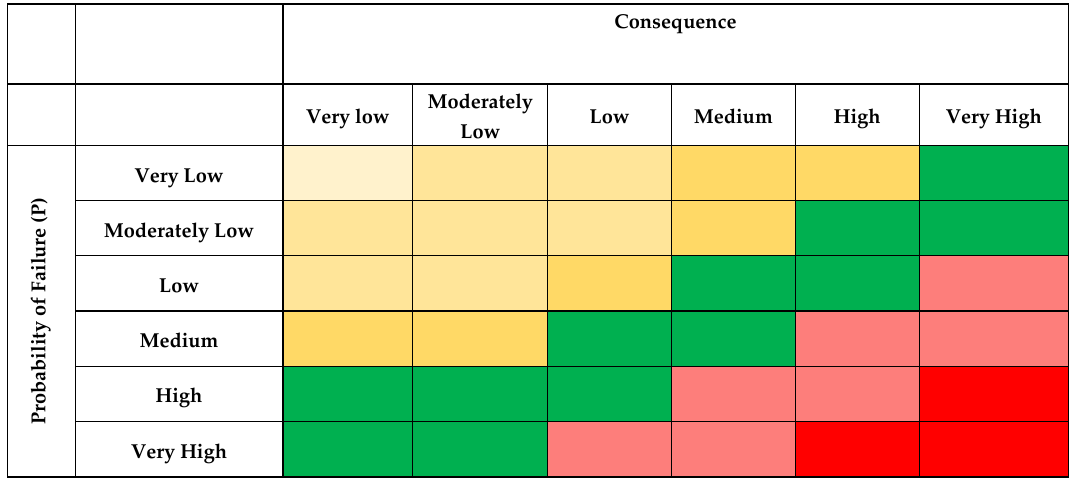
Table 4. Summary of water quality monitoring results for Water Supply System-I during the assessment period between 2016 and 2018.